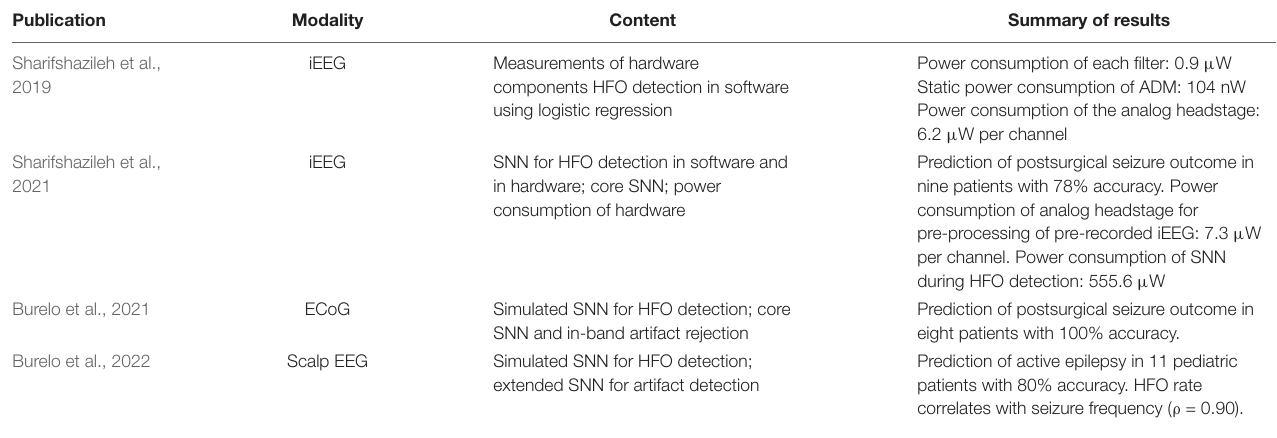
TABLE 1 | SNN for HFO detection in different recording